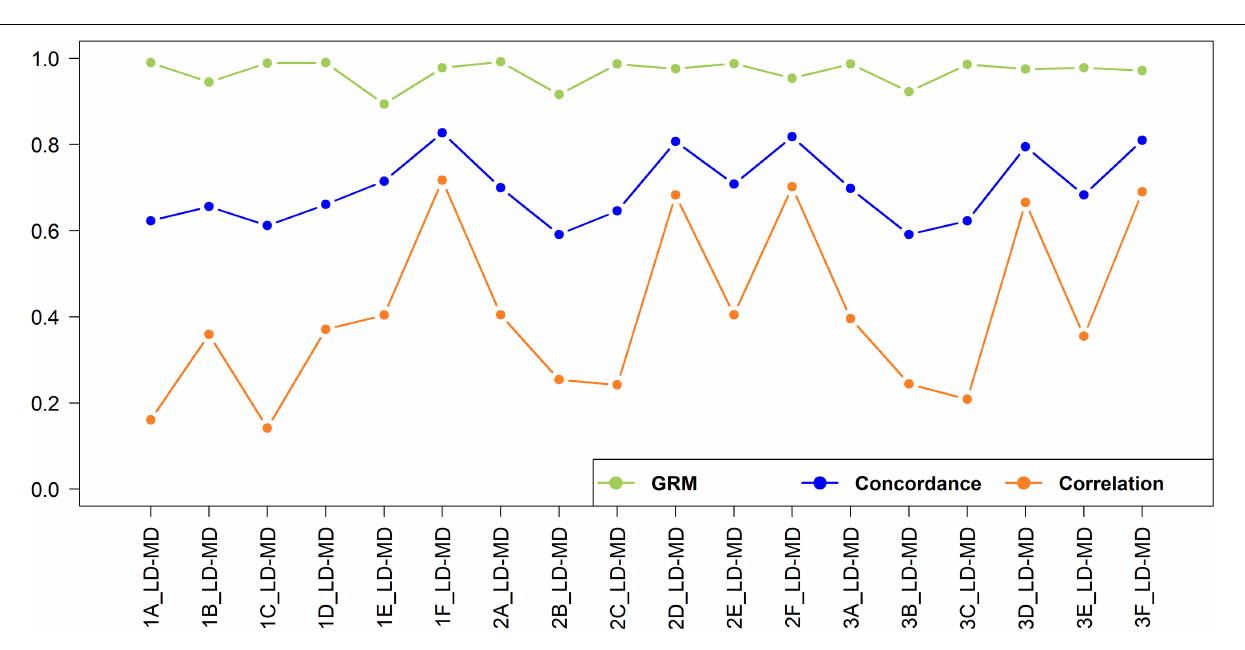
FIGURE 9 | Genotype imputation accuracy and GRM correlation between real and imputed genotypes for imputation from low to